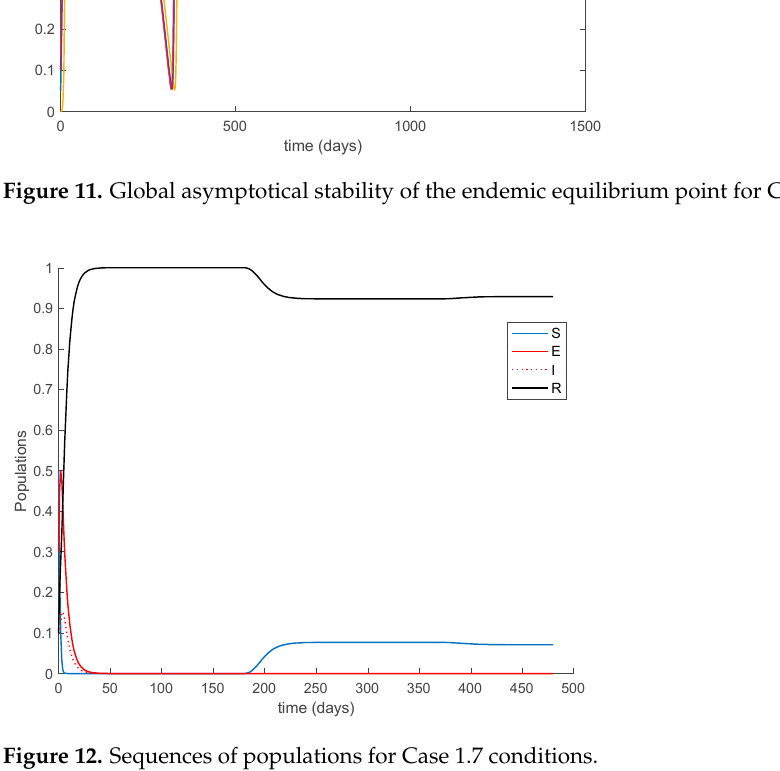
Figure 12. Sequences of populations for Case 1.7 conditions.